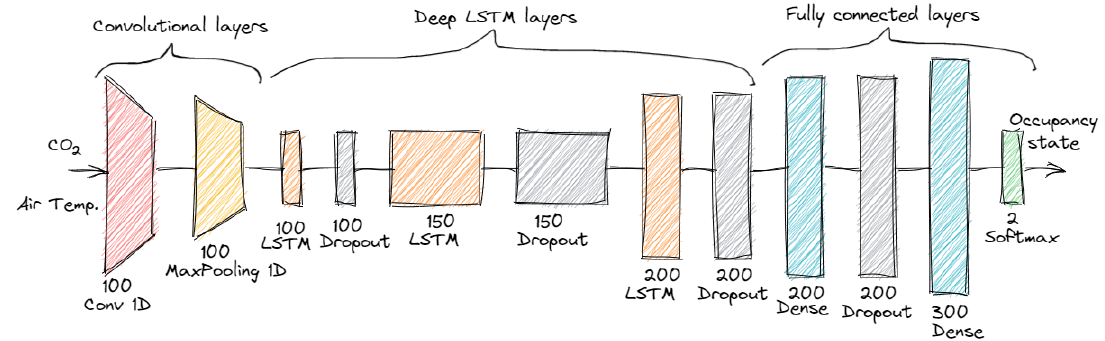
Figure 2. Architecture of the CDLSTM model used in this work with respective layer